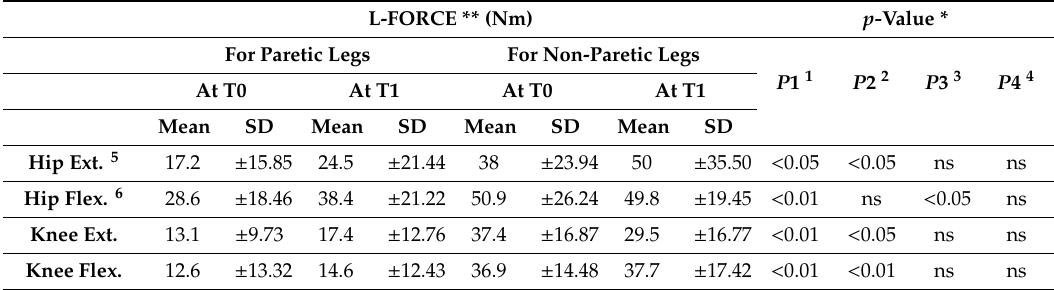
* p -value obtained using Wilcoxon signed-rank test; statistically significant at p < 0.05; ns = non-significant. ** L-FORCE = Lower limb-force. 1 P 1 = p -value comparing L-FORCE at basal assessments (T0) between paretic legs and non-paretic legs. 2 P 2 = p -value comparing L-FORCE at one-month follow-up (T1) between paretic legs and non-paretic legs. 3 P 3 = p -value comparing L-FORCE of paretic legs at T0 and T1. 4 P 4 = p -value comparing L-FORCE of non-paretic legs at T0 and T1. 5 Ext . = Extension. 6 Flex . = Flexion.